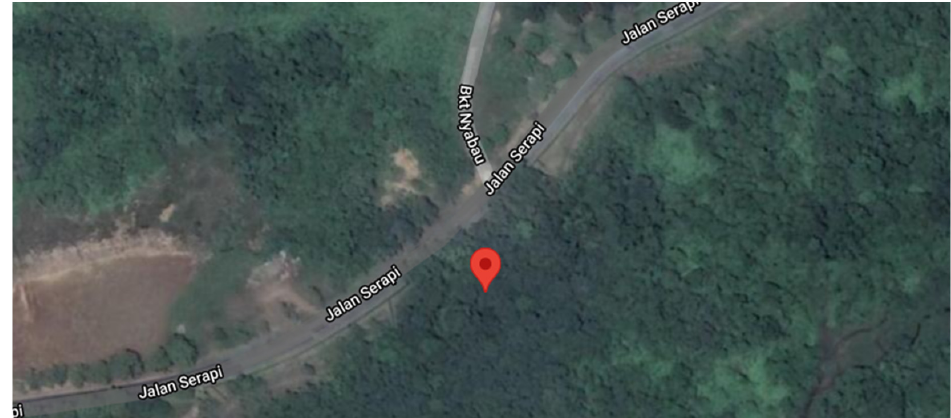
Figure 1. Aerial view of location where soil was sampled for incubation study in Universiti Putra Malaysia Bintulu Sarawak Campus, Malaysia.